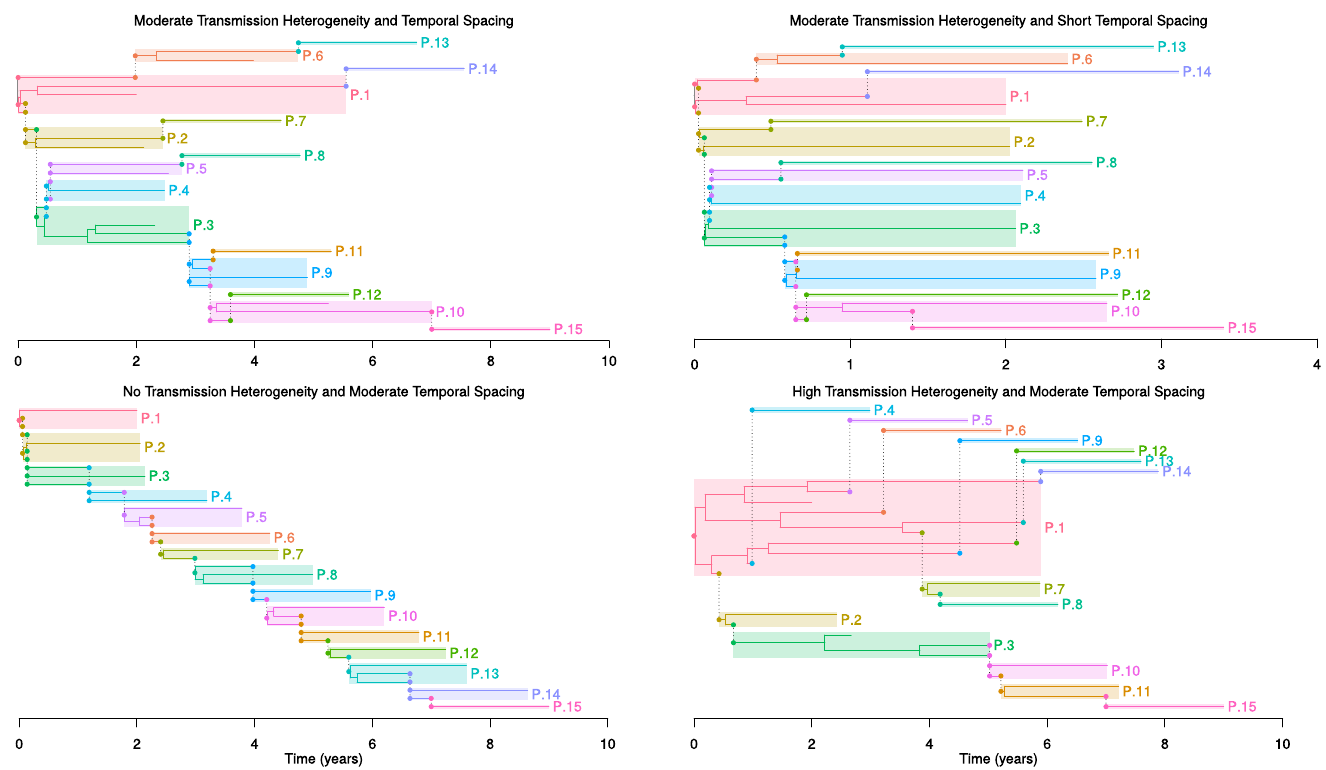
Fig 3. Examples of Simulated Transmission Histories. Four different possible transmission histories and phylogenies. As in Fig 1, each host is indicated by a colored box and transmissions are indicated by dashed vertical lines. Because transmission after diagnosis is not prohibited in these examples, it is possible that the right side of the box for some individuals to extend beyond the sampling time, in which case the right side of the box is the time of the last transmission and the sampling time is the point of termination of a lineage in the interior of the box. Note also that although we only sample one lineage here, the model takes within-host diversity into account, and thus can infer which lineage(s) within the host’s diversity that was transmitted. The Top Left Panel shows a transmission history with moderate temporal spacing (0.5 years) and transmission heterogeneity (near 1). The Top Right Panel shows a transmission history with moderate transmission heterogeneity (near 1) and short temporal spacing (0.1 years). The Bottom Left Panel shows a transmission history with no transmission heterogeneity, leading to a straight transmission chain. The Bottom Right Panel shows a transmission history with high transmission heterogeneity involving a super-spreader